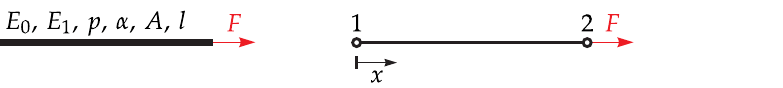
Figure 7. Fractional viscoelastic rod ( left ) described as a two-node one-dimensional finite element ( right